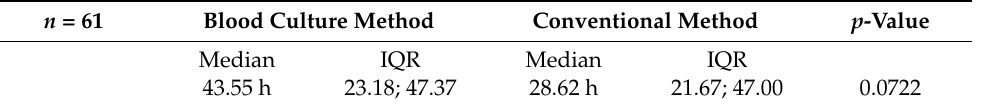
Table 5. Time to Result.